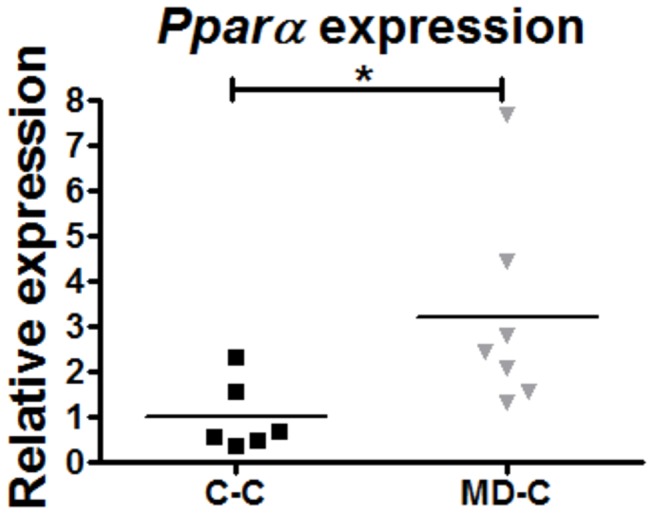
Increased expression of Ppara in prenatally MD supplemented young adult mice.
Ppara expression by real-time RT-PCR measurements from colonic mucosal scrapings showed increased expression in the MD-C animals compared to C-C at P90 (U test, p=0.022; n=6-7).